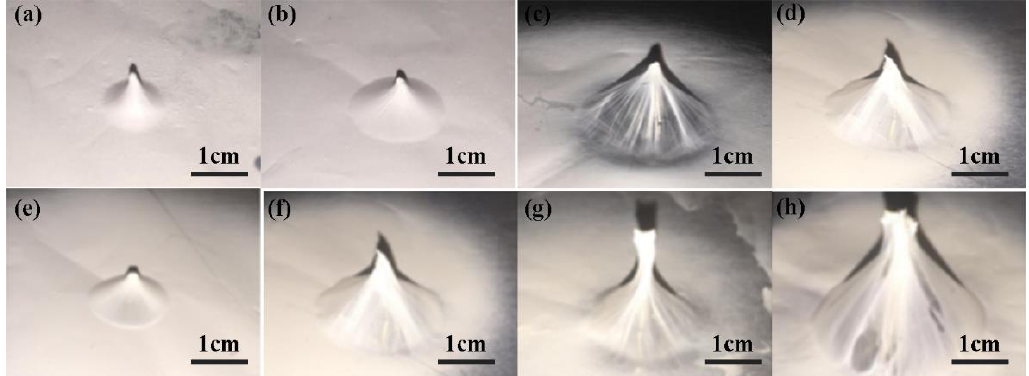
Figure 3. 3D nanofibrous structures printed on a single probe. ( a ) 12 kV and ( b ) 20 kV with 5 mm probe height; ( c ) 12 kV and ( d ) 20 kV with 10 mm probe height; ( e ) 5 mm, ( f ) 10 mm; ( g ) 15 mm; ( h ) 20 mm with applied voltage of 20 kV. The flow rate was 300 μL/ h.